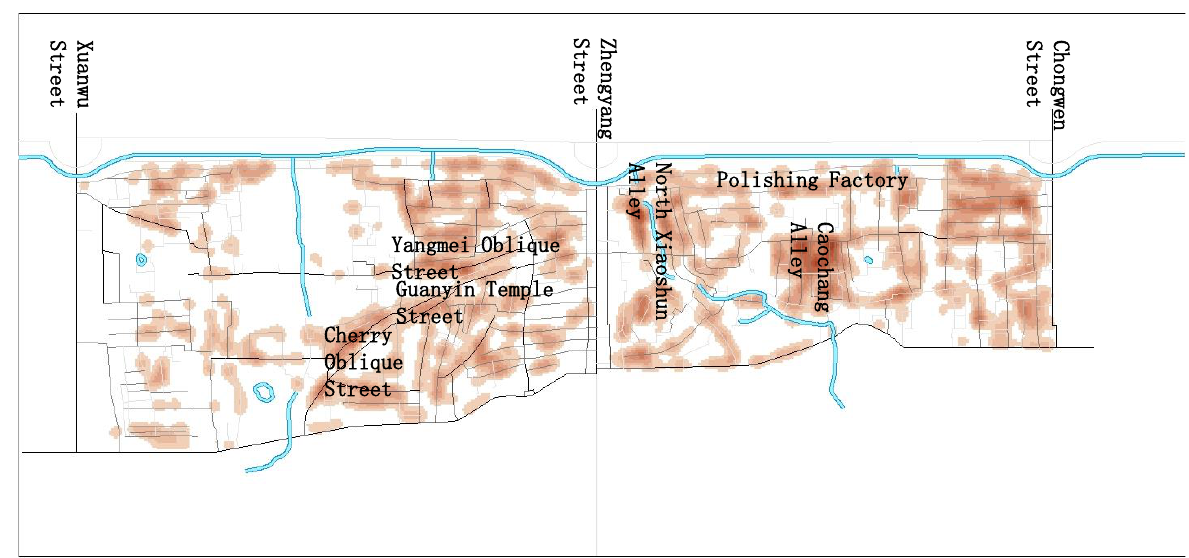
Figure 10. Distribution characteristics of architecture